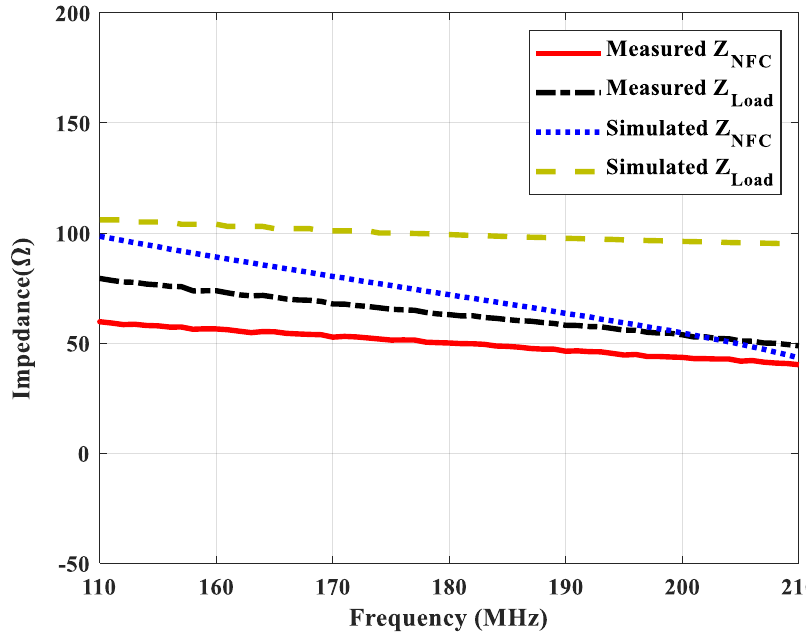
Figure 4. The simulated and measured impedance values of load and non-Foster circuit.